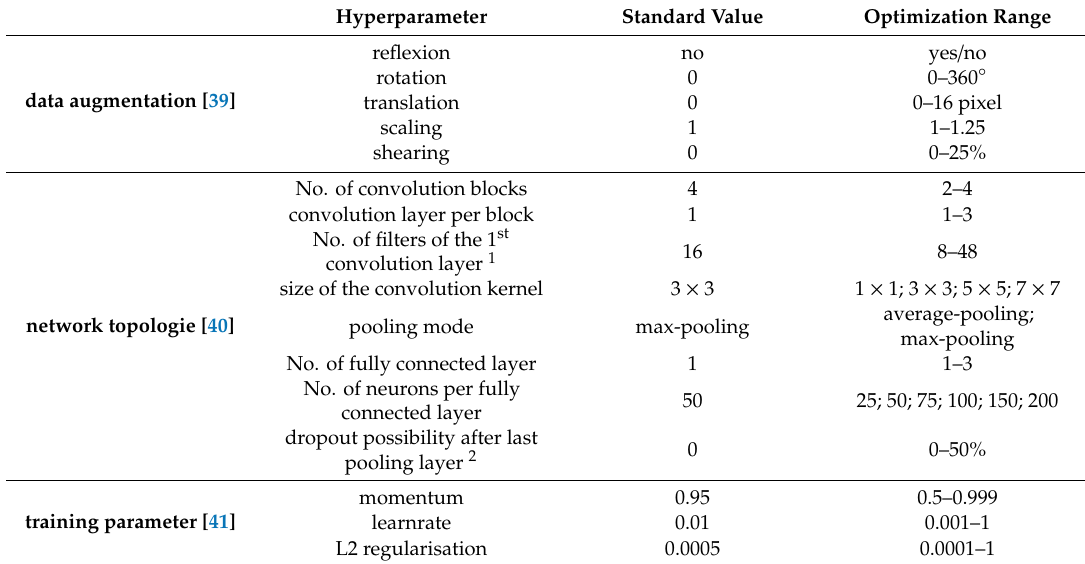
Table A2. Overview of the optimization ranges of the hyperparameters of the CNN models. For a description of the hyperparameters, please refer to the literature references.